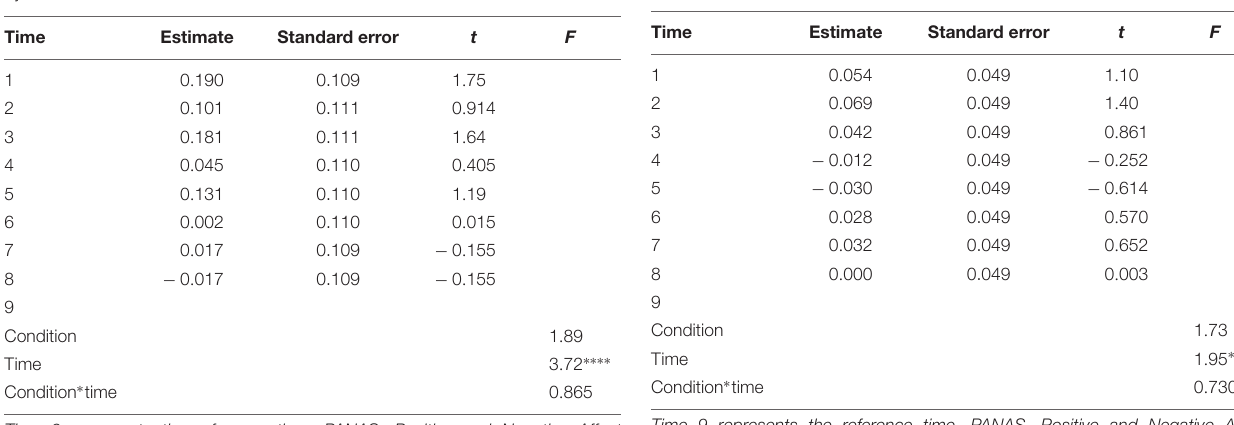
FIGURE 5 | Mean scores on Positive Affect (PA) for the restricted ( n = 67) and control ( n = 60) condition. The error bars represent standard error mean for each value. † p < 0.001 for main effect of time. TABLE 6 | The effect of smartphone restriction on negative affect (PANAS) scores by linear mixed